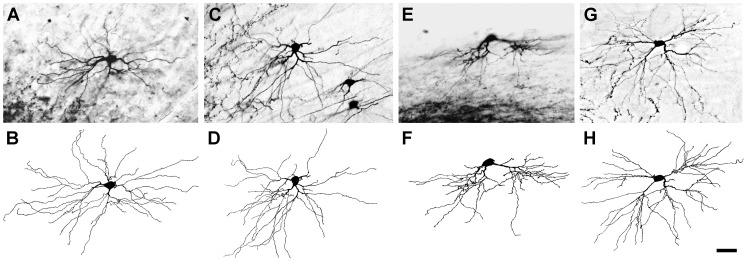
dLGN projection neurons labeled by injections of BDA into the visual cortex.The micrograph of each cell is accompanied by a camera lucida drawing of the cell to illustrate all labeled dendrites, particularly those that are out of focus in the plane of the micrograph. (A, B) A radial cell from an unlesioned rat with dendrites arrayed around the cell soma. (C, D) A basket cell from an unlesioned rat with dendrites distributed asymmetrically. (E, F) A bipolar cell from an unlesioned rat with dendrites emerging from two poles of the cell soma spaced approximately 180° apart. (G, H) A radial cell from a rat that received a lesion of the contralateral visual cortex 48 hours prior. Images adapted in part from [32]. Scale bar: 50 µm.